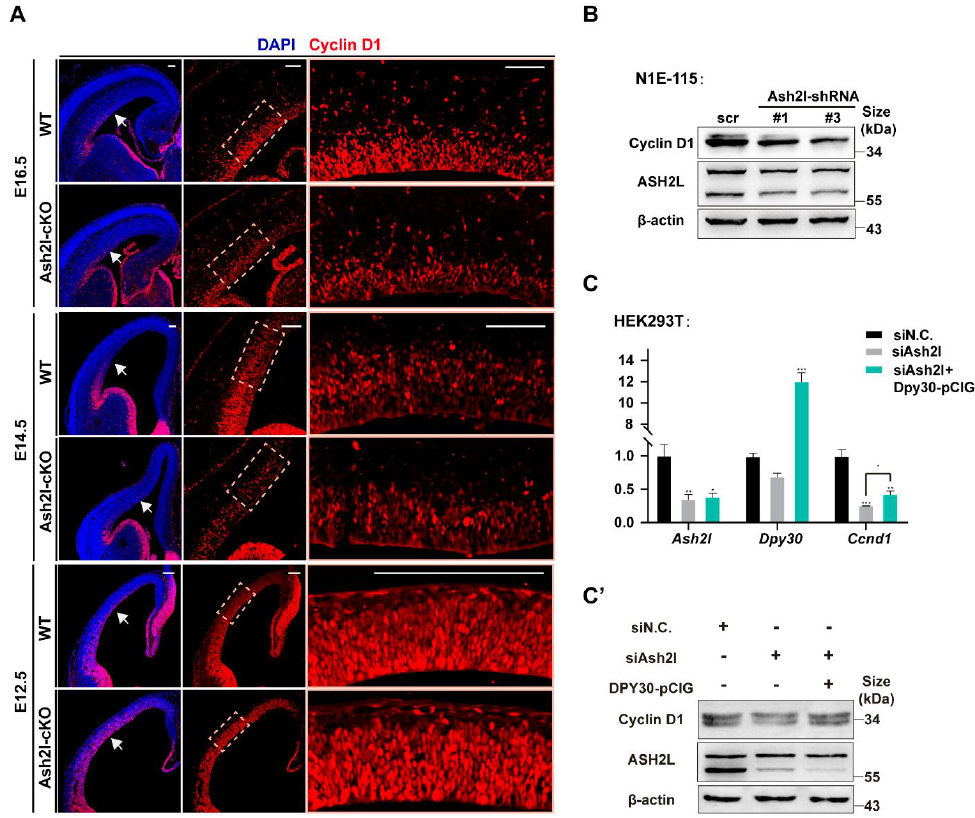
Figure 5. DPY30 ameliorates the outcome of Ash2l depletion ( A ) Immunofluorescence of Cyclin D1 in the dorsal neocortex of WT and Ash2l-cKO mice at E12.5, E14.5, and E16.5. ( B ) Ash2l-shRNA was